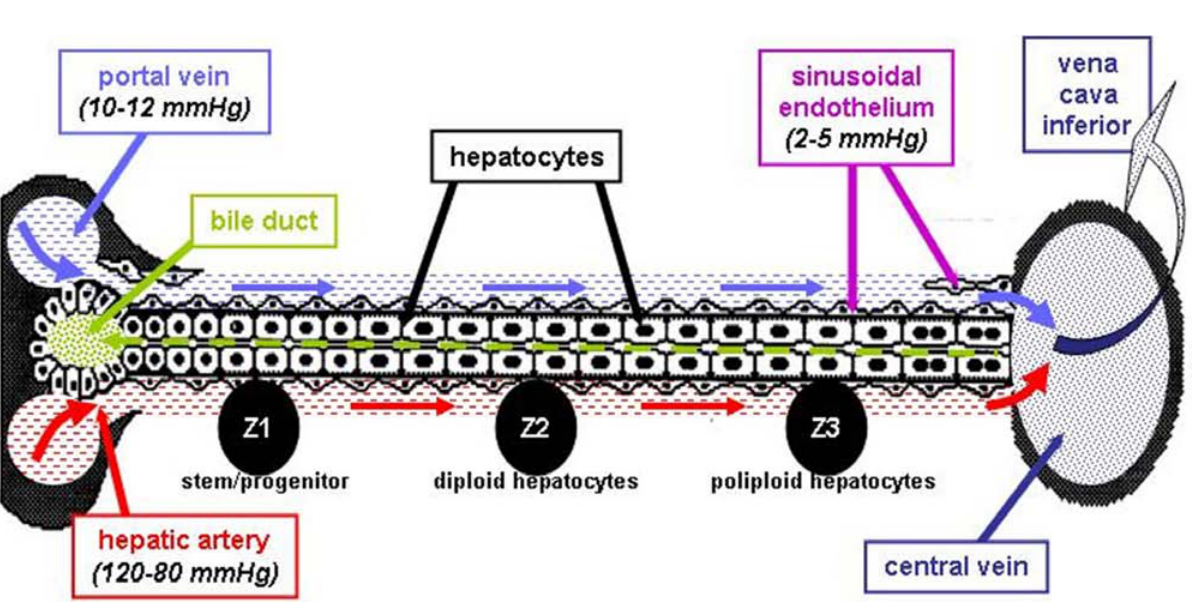
Figure 2. A schematic representation of the nutritional (hepatic artery) and functional (portal vein) blood supply in the liver, emphasizing differences in blood pressure between the